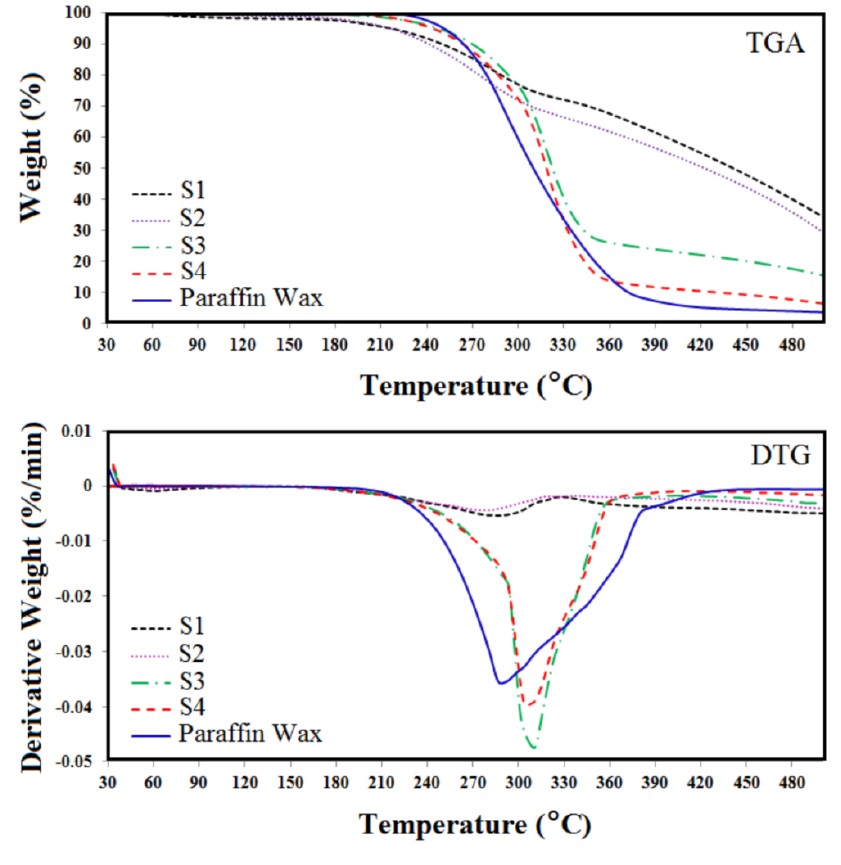
Figure 2. Thermal Gravimetry Analysis (TGA) and Differential Thermal Gravimetry (DTG) results of microencapsulated S1, S2, S3, S4 and paraffin